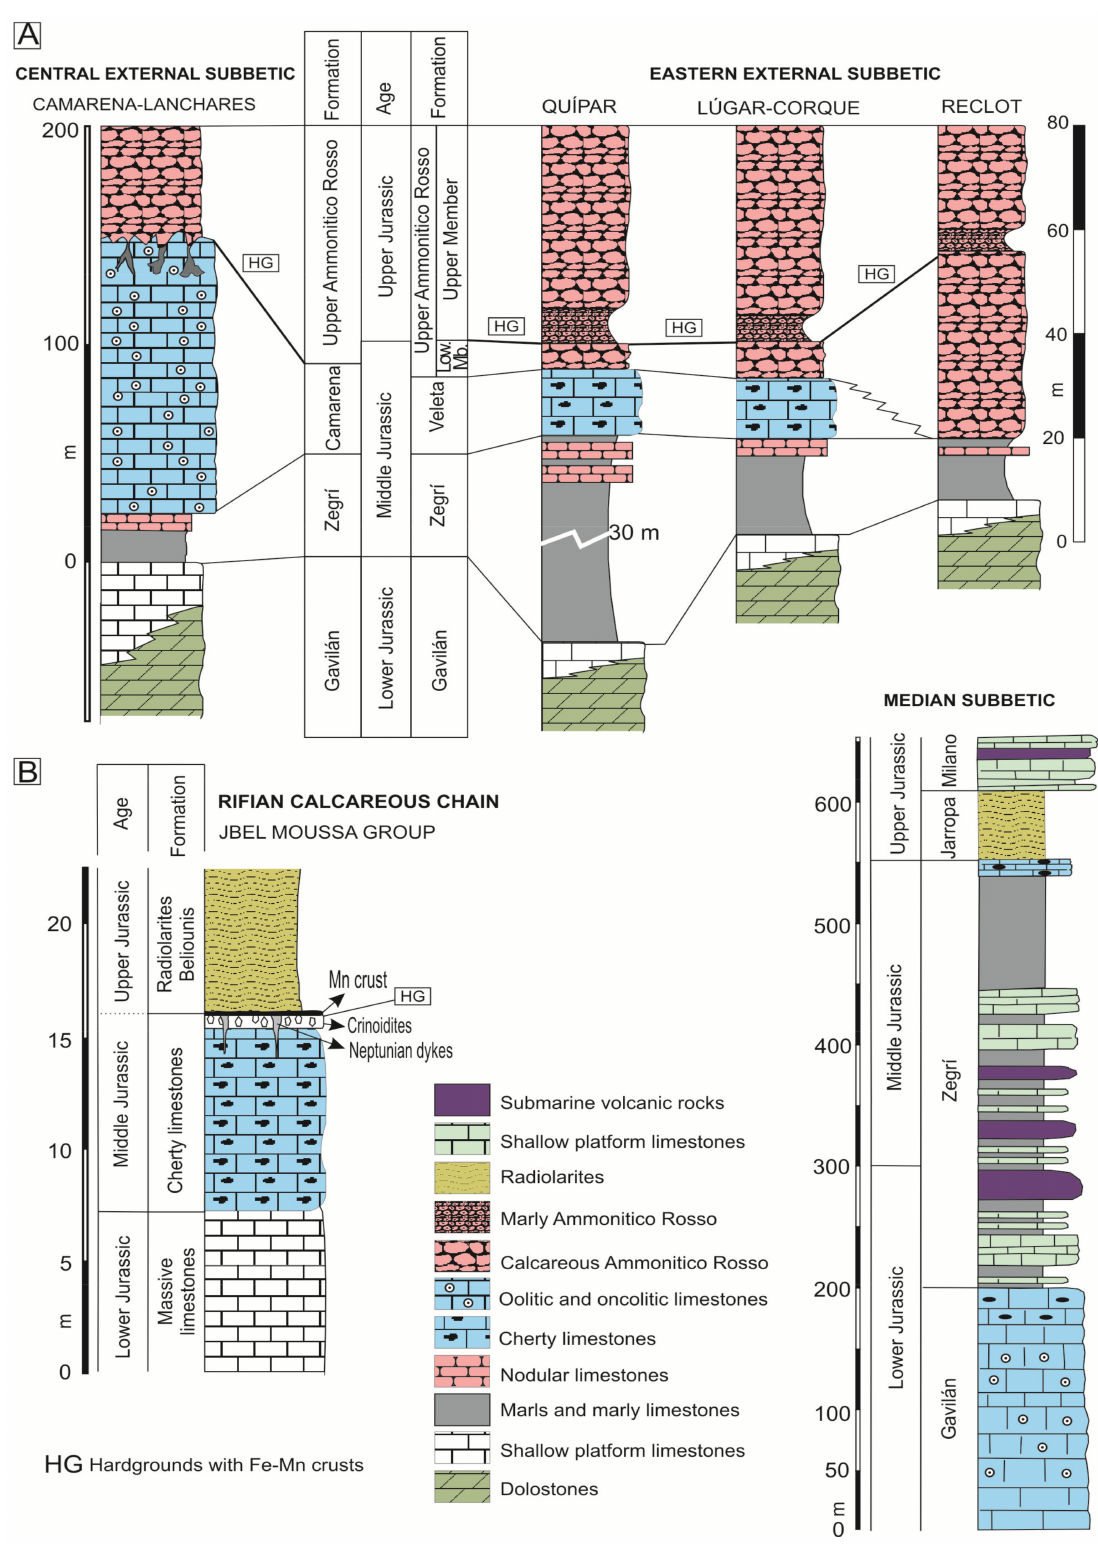
Figure 3. Synthetic stratigraphic sections of the Jurassic in the different tectonic units studied for the External and Median Subbetic ( A ) and the Rifian Calcareous Chain ( B